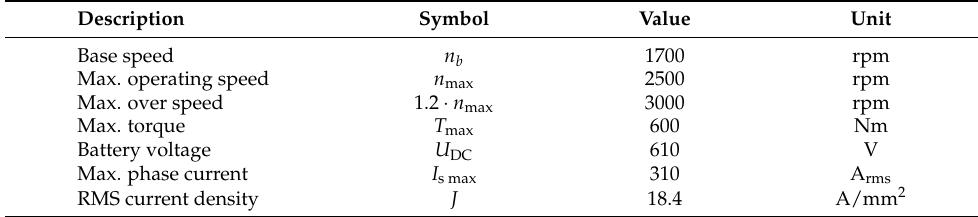
Table 1. Peak operation requirements at base